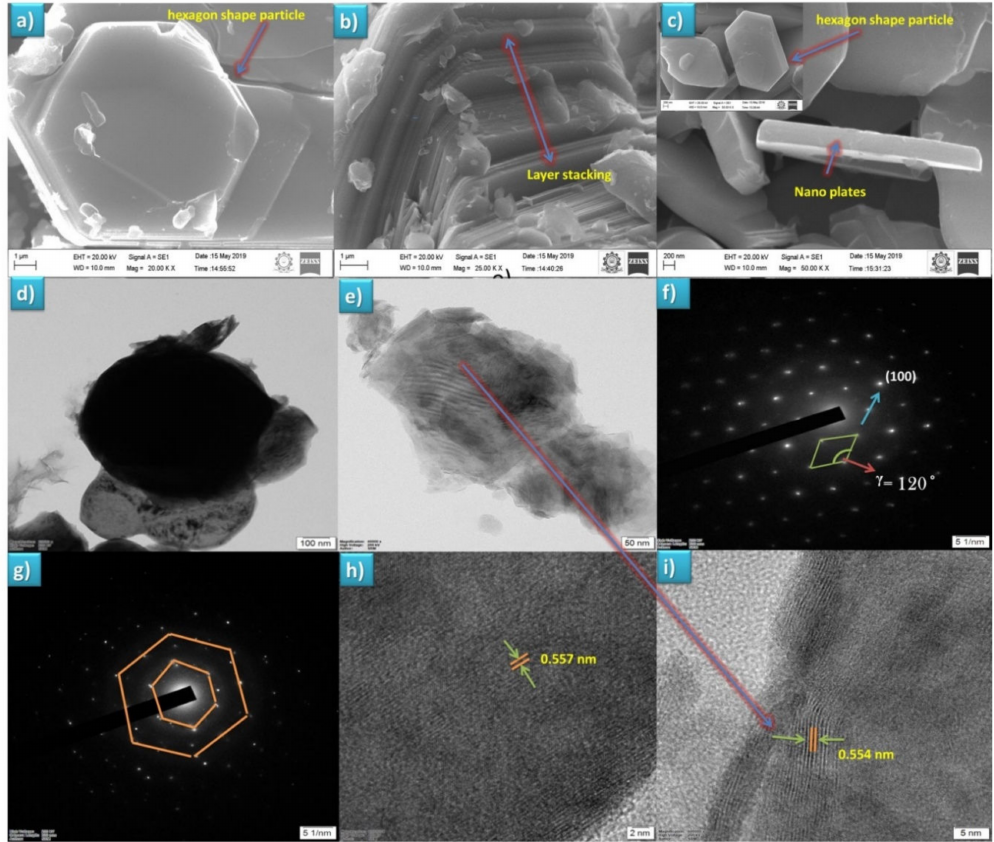
Figure 2. ( a , b ) SEM images of sample P2-Na 2 / 3 Ni 1 / 3 Mn 2 / 3 O 2 prepared via the SSR method, ( c ) SEM images of sample P2-Na 2 / 3 Ni 1 / 3 Mn 2 / 3 O 2 prepared via the SGR method, ( d ) HR-TEM image of sample P2-Na 2 / 3 Ni 1 / 3 Mn 2 / 3 O 2 prepared via SSR, ( e ) HR-TEM image of sample P2-Na 2 / 3 Ni 1 / 3 Mn 2 / 3 O 2 prepared via SGR, ( f ) SAED pattern of sample P2-Na 2 / 3 Ni 1 / 3 Mn 2 / 3 O 2 prepared via the SGR method, ( g ) SAED pattern of sample P2-Na 2 / 3 Ni 1 / 3 Mn 2 / 3 O 2 prepared via the SSR method, and ( h , i ) lattice fringes of samples P2-Na 2 / 3 Ni 1 / 3 Mn 2 / 3 O 2 prepared via SSR and SGR,